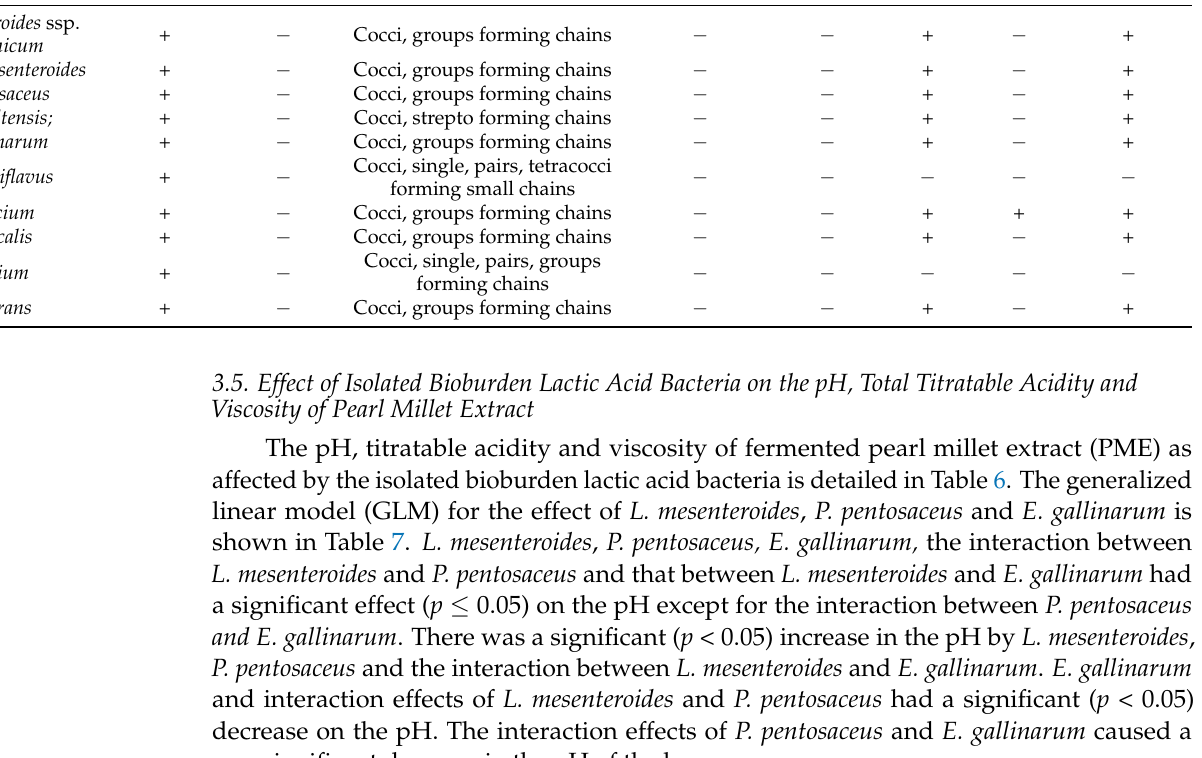
Table 5. Physiological properties of tentative lactic acid bacteria isolated from pearl millet slurry during fermentation. Lactic Acid Bacteria